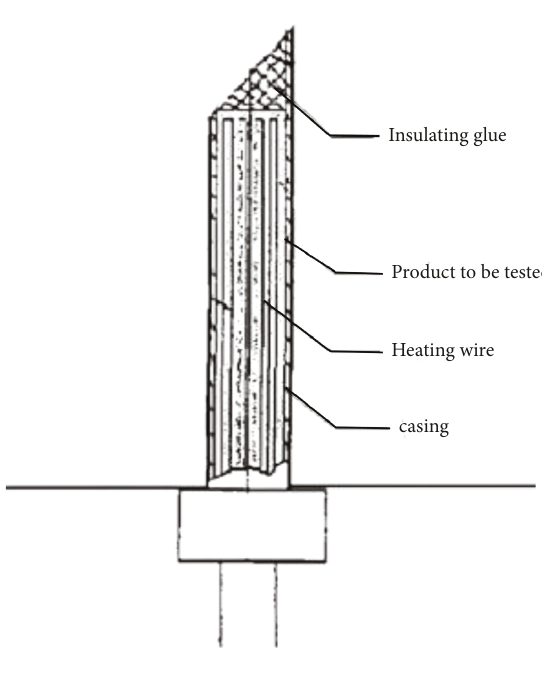
Figure 3: Schematic diagram of thermal